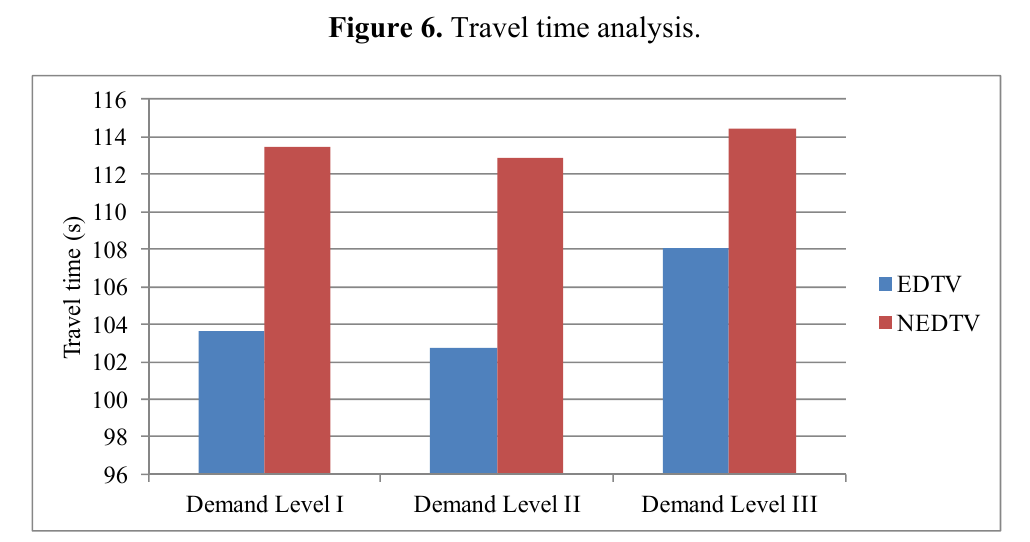
( C ) Demand Level III.